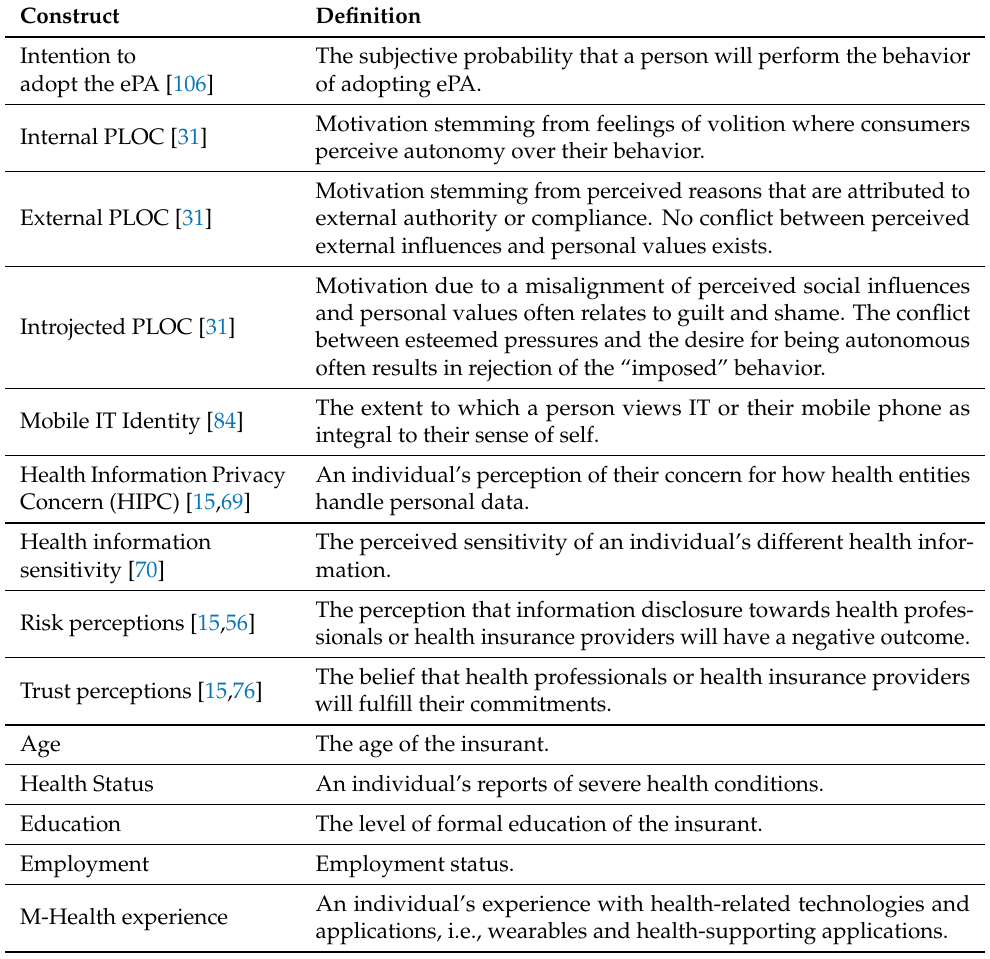
Table 1. Constructs and their